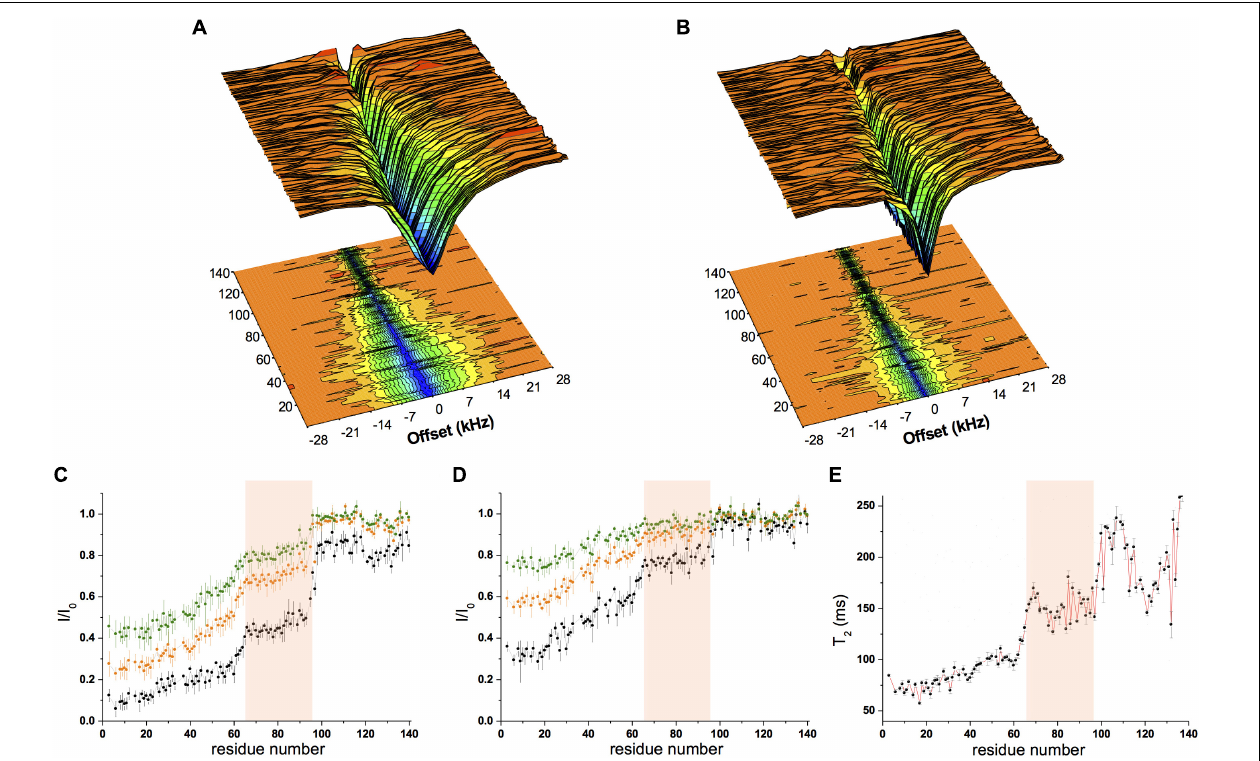
FIGURE 2 | Conformational properties of α S binding to acidic SUVs. (A–D) CEST experiments were recorded at a 1 H frequency of 700 MHz (see section “Materials and Methods”), using a protein concentration of 300 µ M and 0.06% (0.6 mg/ml) of SUV-31%. The concentration of SUV-31% was calculated by considering exclusively the DOPE:DOPS:DOPC component of the lipid mixture. 1 H- 15 N CEST spectra were recorded by using a continuous wave saturation (170 Hz or 350 Hz) on the 15 N channel at a range of offsets: − 28, − 21, − 14, − 9, − 5, − 3, − 1.5, 0, 1.5, 3, 5, 9, 14, 21, and 28 kHz. An additional spectrum saturated at –100 kHz was recorded as a reference. CEST surface was measured using a saturation bandwidth of 350 Hz (A) and 170 Hz (B) and the saturation along the α S sequence (350 Hz and 170 Hz in panels (C,D) , respectively) is shown. Black, orange and green lines refer to the averaged CEST profiles measured using offsets at ± 1.5 kHz, ± 3.0 kHz, and ± 5.0 kHz, respectively. (E) T 2 values from transverse relaxation measurements [experimental conditions as in panels (A–D) ]. The pink background in panels (C–E) evidences region 65–97, where a reduction in binding compared to the preceding segment is observed in both CEST (reduced saturation) and relaxation (higher T 2 values) measurements.